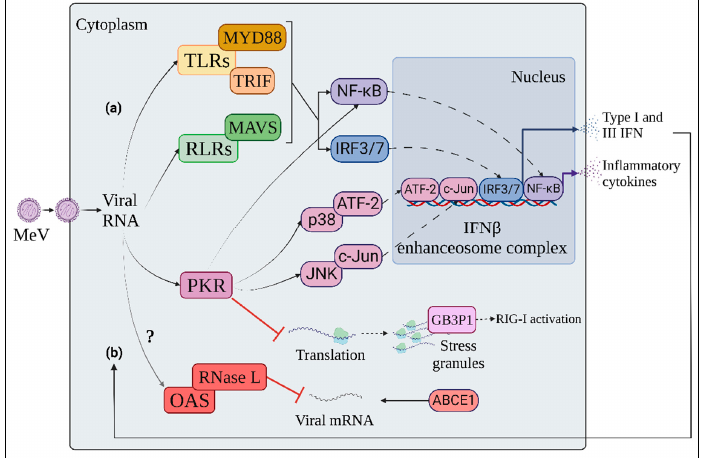
Figure 1. Innate immune response to MeV. ( a ) Soon after MeV penetration into target cells, endo-plasmic or cytosolic viral RNA is detected by TLRs and RLRs, respectively, triggering the activation of MyD88, TRIF and MAVS adaptor molecules. The three axes of RNA-dependent innate immune response converge in the activation of NF-kB, IRF3 and 7 transcription factors, in-ducing both inflammatory cytokines and IFN expression. ( b ) IFN-inducible antiviral molecules, such as PKR and OAS, are activated in an autocrine and paracrine manner through interaction with viral RNA. This IFN-inducible stress response contributes to limiting viral protein production through inhibition of viral translation, selective degradation of viral mRNAs and IFN response enhancement. Orange: TLR signaling axis; Green: RLR signaling axis; Pink: PKR-mediated stress response; Red: OAS-mediated stress response; Blue: IRF transcription factors; Purple: NF-kB transcription